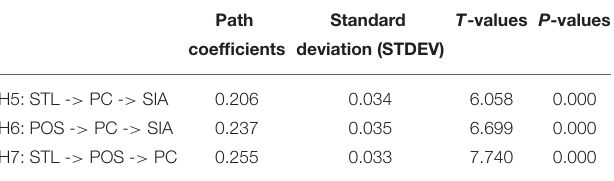
TABLE 5 | Indirect effects